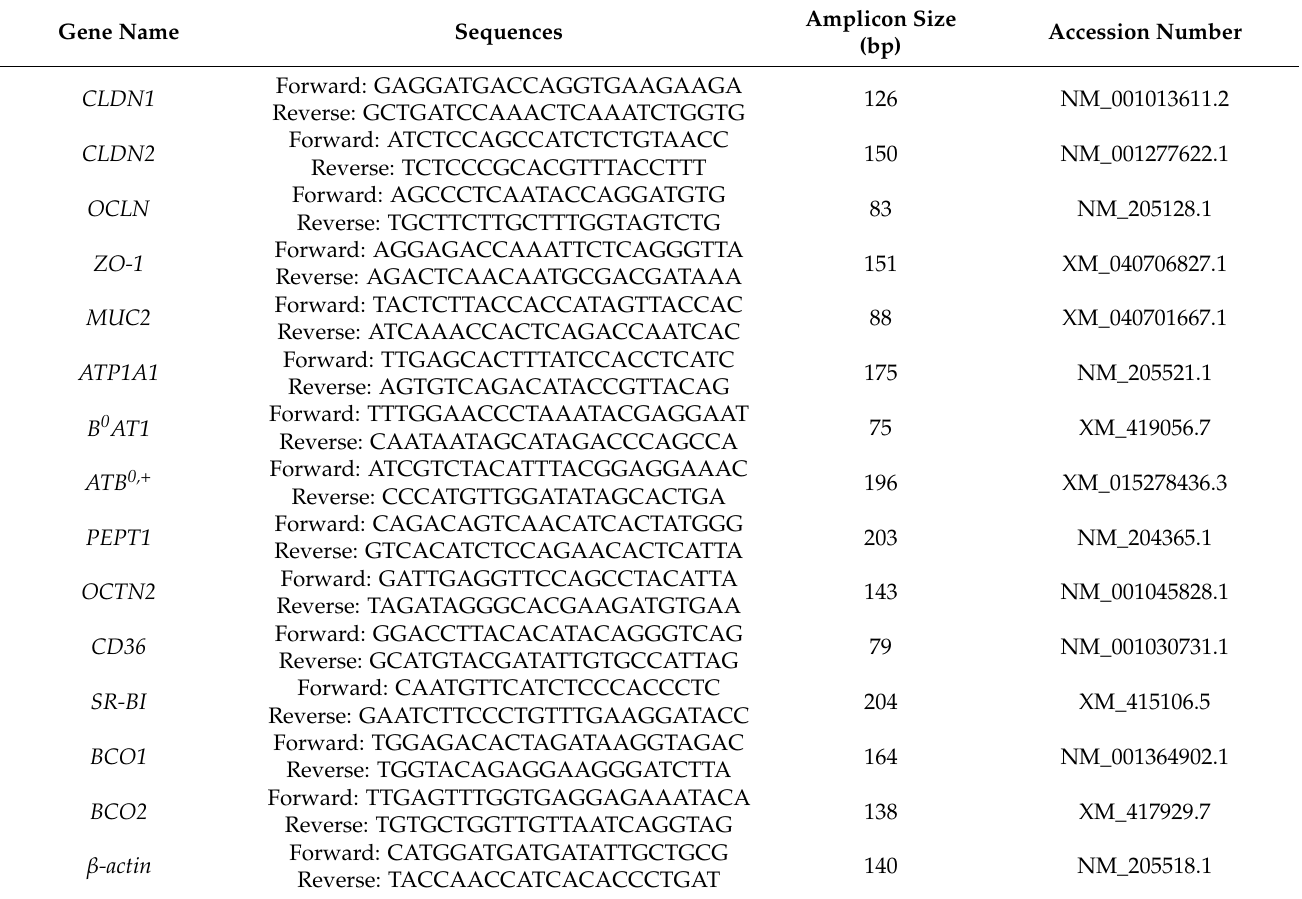
Table 2. Primer sequences were used for RT-qPCR in this